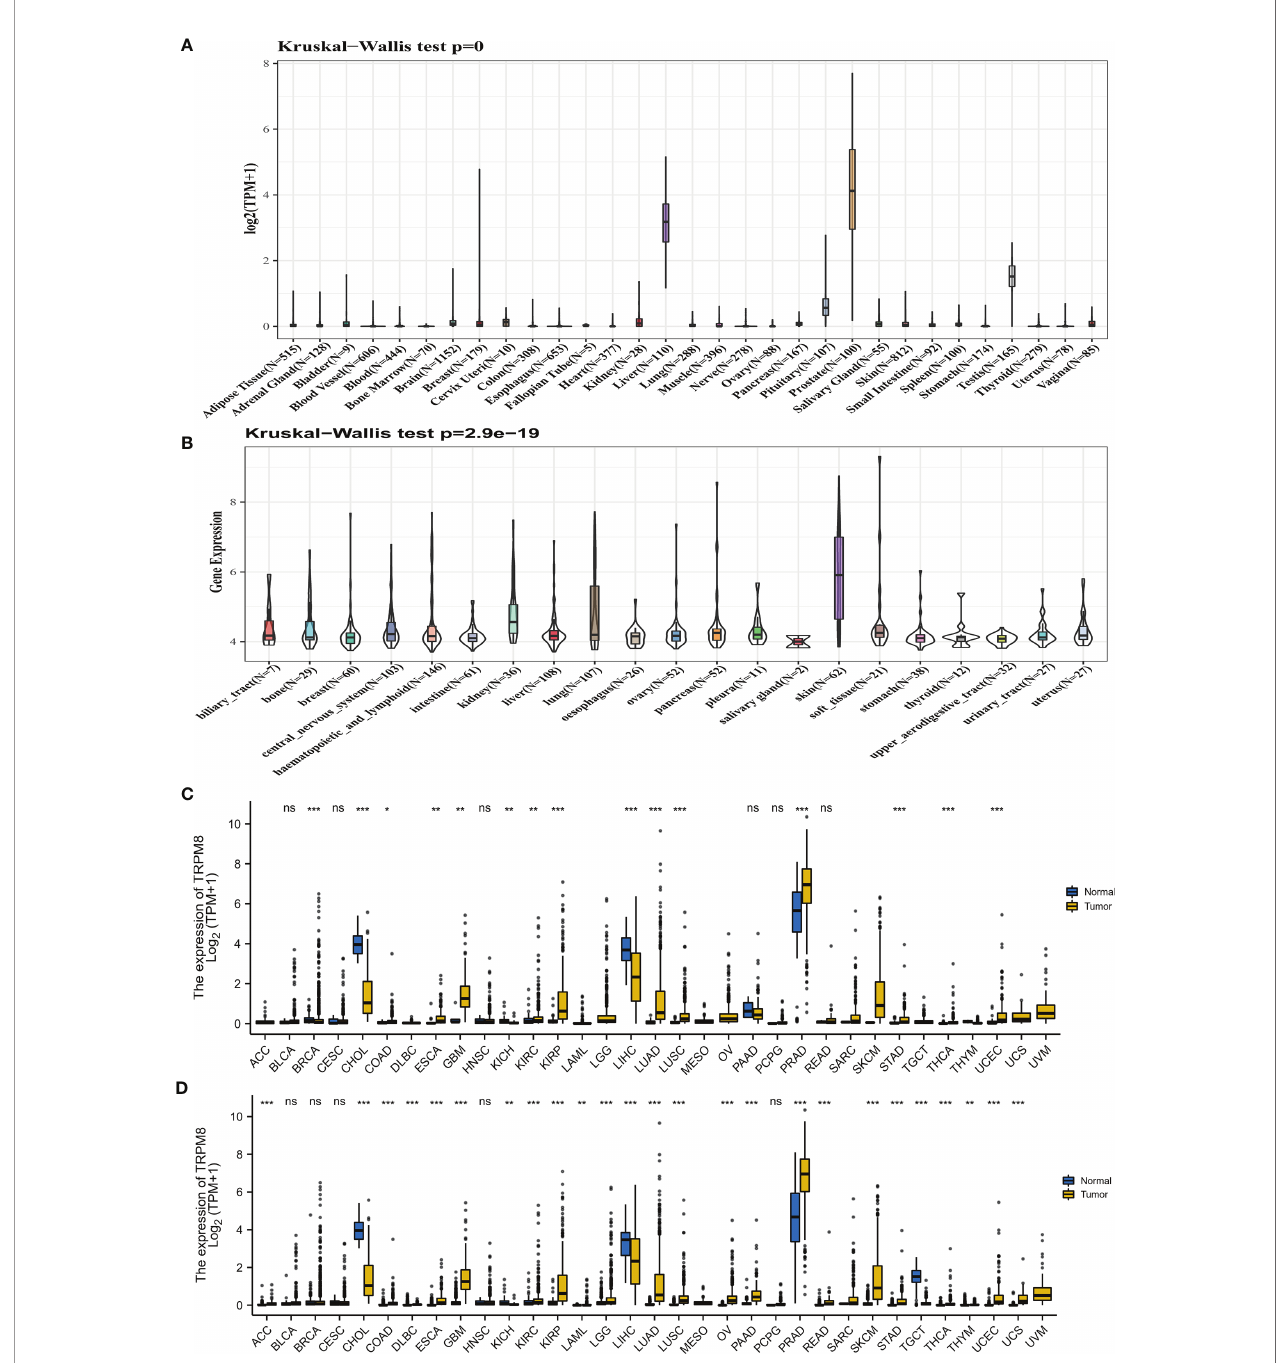
FIGURE 1 | TRPM8 levels in tumor tissues. (A) TRPM8 levels in 31 cancers, from GTEx. (B) TRPM8 levels in 21 cell lines, from CCLE. (C) TRPM8 levels in 33 pairs of tumor and non-tumor tissues, from TCGA. *P < 0.05, **P < 0.01, and ***P < 0.001. (D) TRPM8 differential expression in 33 cancers, from integrated GTEx and TCGA data, ns, no signi fi cance, *P < 0.05, **P < 0.01, ***P <